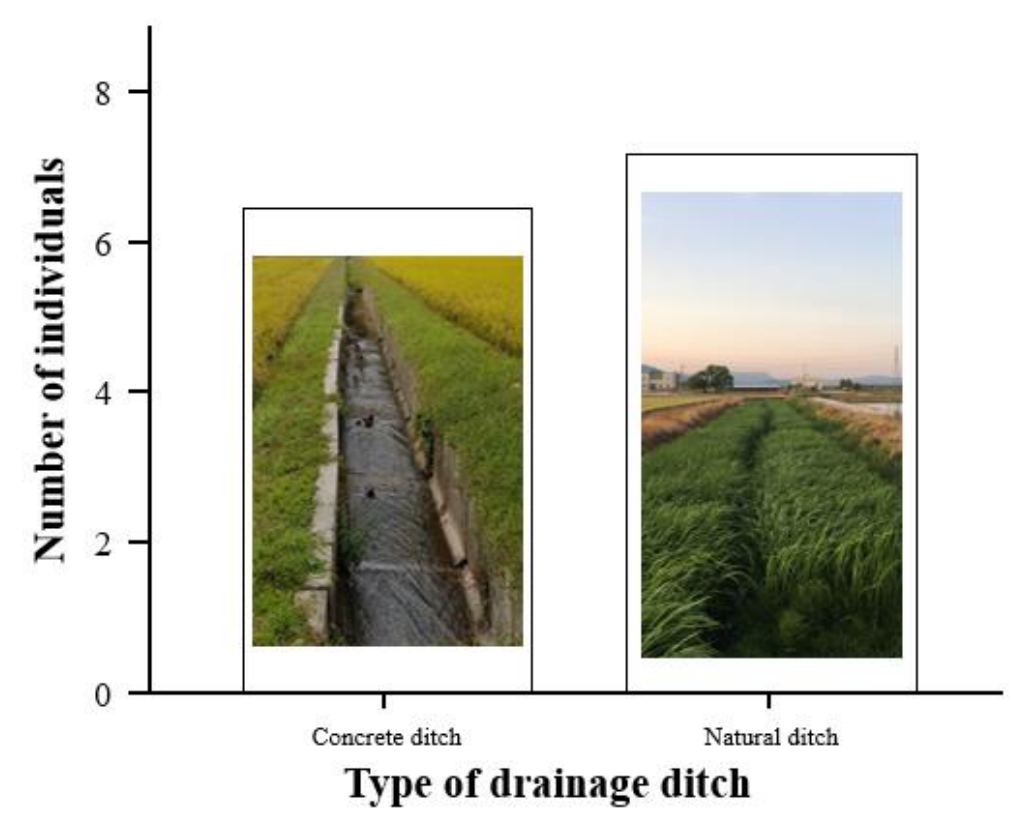
Figure 2. Mix-species anuran assemblage encountered by ditch type. We recorded the absence and presence of Pelophylax nigromaculatus , P. chosenicus, Lithobates catesbeianus , Dryophytes japonicus and Rana sp. in agricultural ditches in North Jeolla province, Republic of Korea, between May and June, from 2014 to 2016.